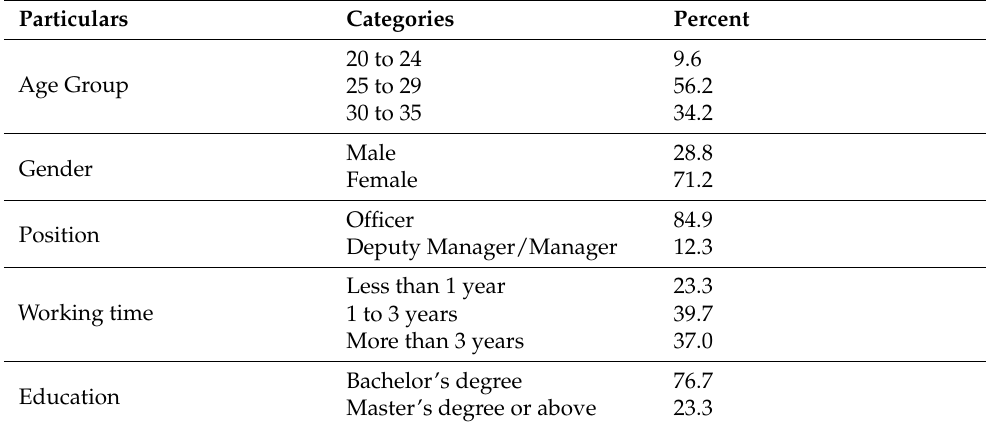
Table 1. Demographic Profiles of